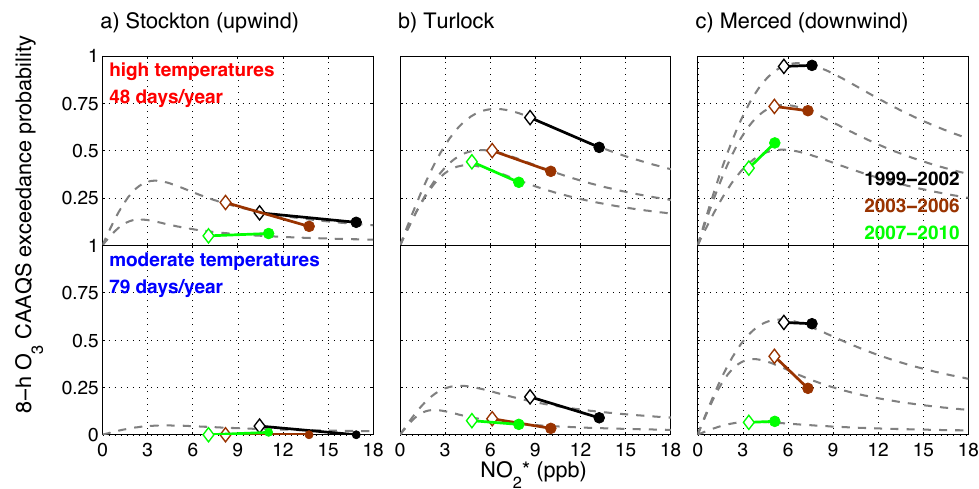
Fig. 10. Northern SJV four-year medians of 8-h O 3 exceedance probabilities vs. NO 2 * tethering weekdays (circles) and weekends (diamonds) for 1999–2002 (black), 2003–2006 (brown), and 2007–2010 (green). Data are separated into high- (top) and moderate- (bottom) temperature regimes for Stockton (a) , Turlock (b) , and Merced (c) . Uncertainties in the probability of violations are smaller than the observed year-to-year variability at ± 0.04 (1 σ) for weekdays and ± 0.06 (1 σ) for weekends. Curves (dashed grey lines) were produced as for Fig. 6.